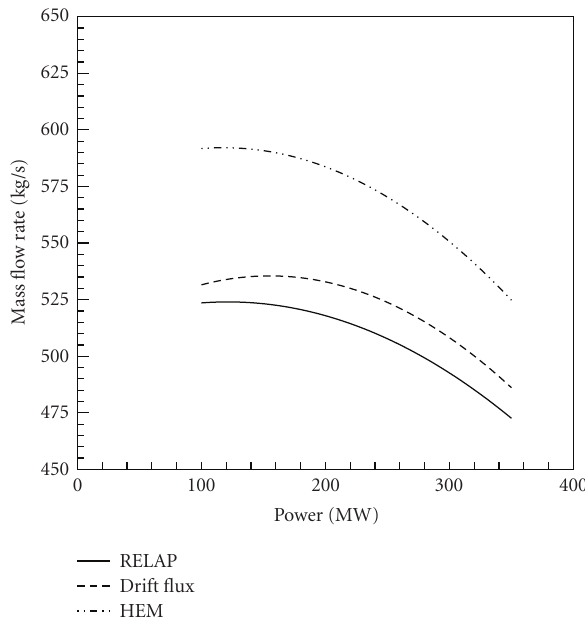
Figure 3: Variation of mass flow rate with